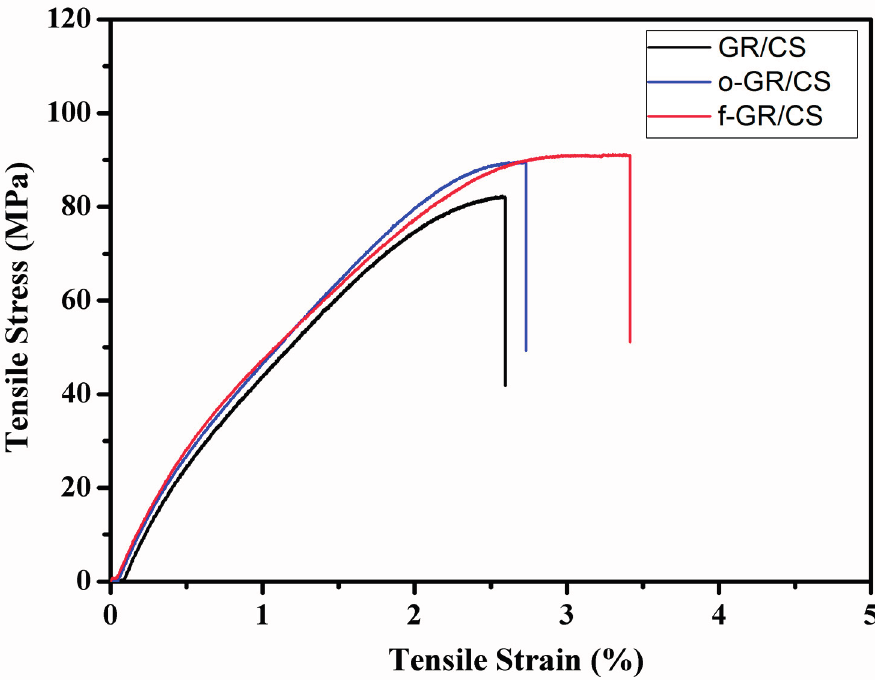
Figure 3. Comparison of stress-strain curves in tensile tests among graphene (GR/CS), o-graphene (o-GR/CS) and f-graphene/chitosan (f-GR/CS) composite films. GR = Graphene; CS = chitosan; o = oxidized; f =